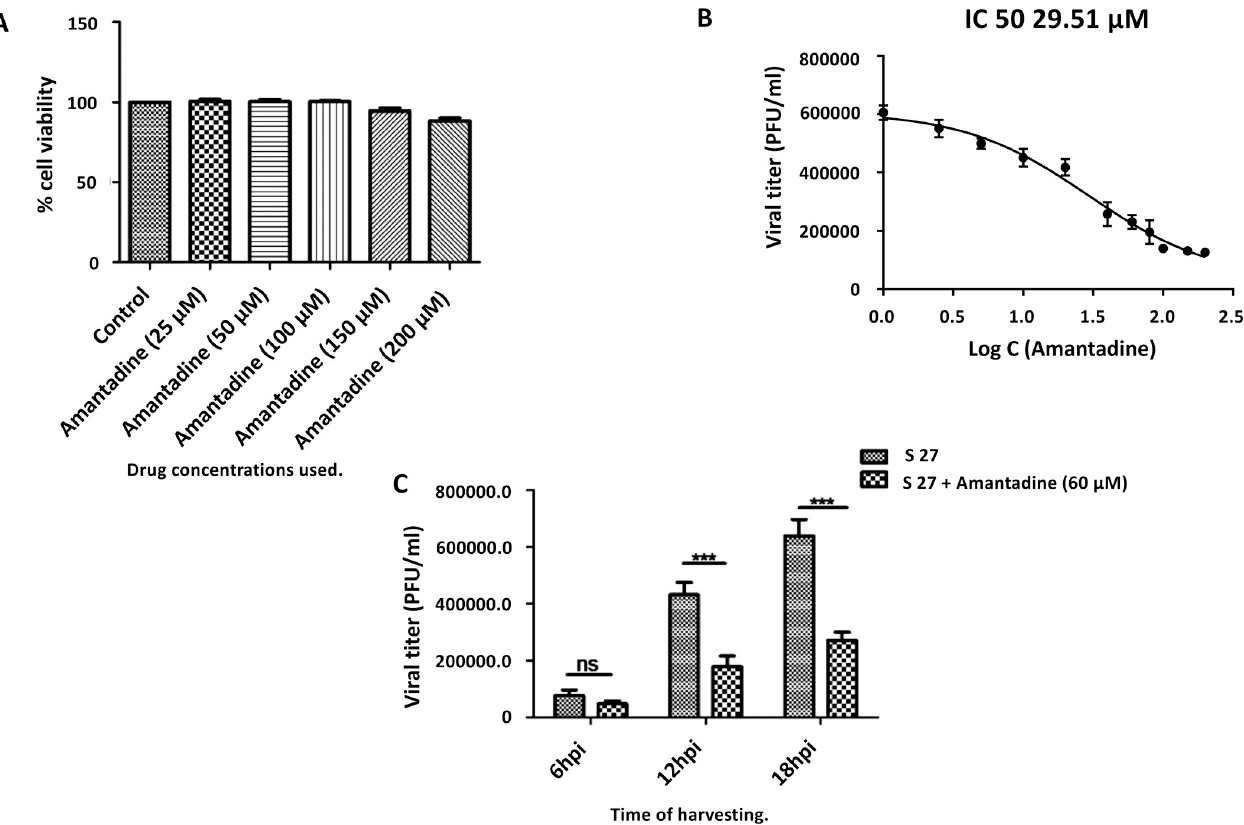
Fig 8. Amantadine inhibits CHIKV infection in vitro : (A) Bar diagram showing percent cellular viability in the presence of different concentrations of amantadine as estimated by MTT assay. (B) Representation of CHIKV inhibition curve, where the x-axis depicts the logarithmic value of the concentration of amantadine and y-axis depicts the PFU/ML. Viral titers were determined through plaque assay from cell culture supernatants of CHIKV infected (MOI 0.1) and drug-treated samples harvested at 18 hpi. (n = 3; p � 0.05). (C) Bar graph showing viral titer of cell culture supernatants of CHIKV infected samples (with and without amantadine). For statistical analysis, Two way ANOVA followed by Bonferroni post-test analysis was carried out for determining the level of significance. N = 3; p < 0.05).